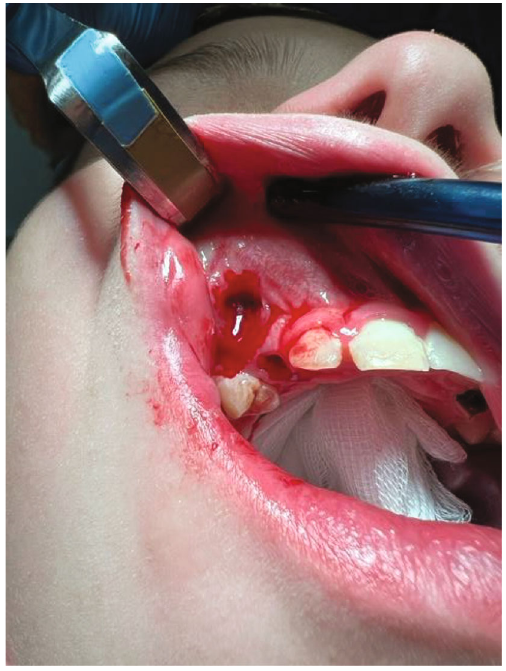
Figure 2: Intraoral view on operative region. Pus discharge is still present despite antimicrobial treatment.